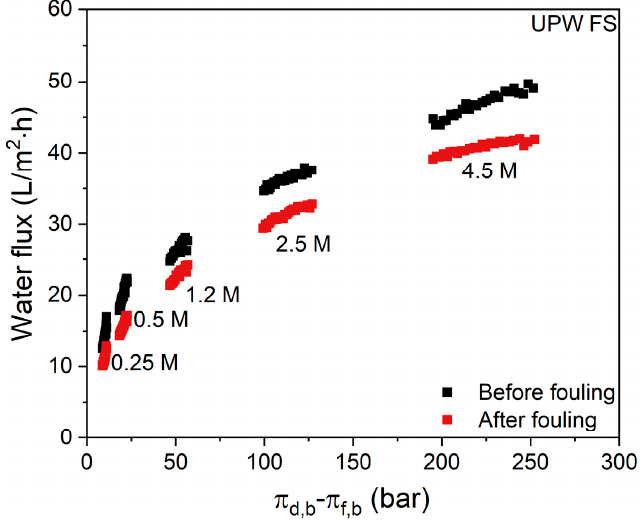
Figure 4. Water flux values before and after the first cycle with whey proteins with various NaCl concentration. FS: UPW. Average values represent two runs.